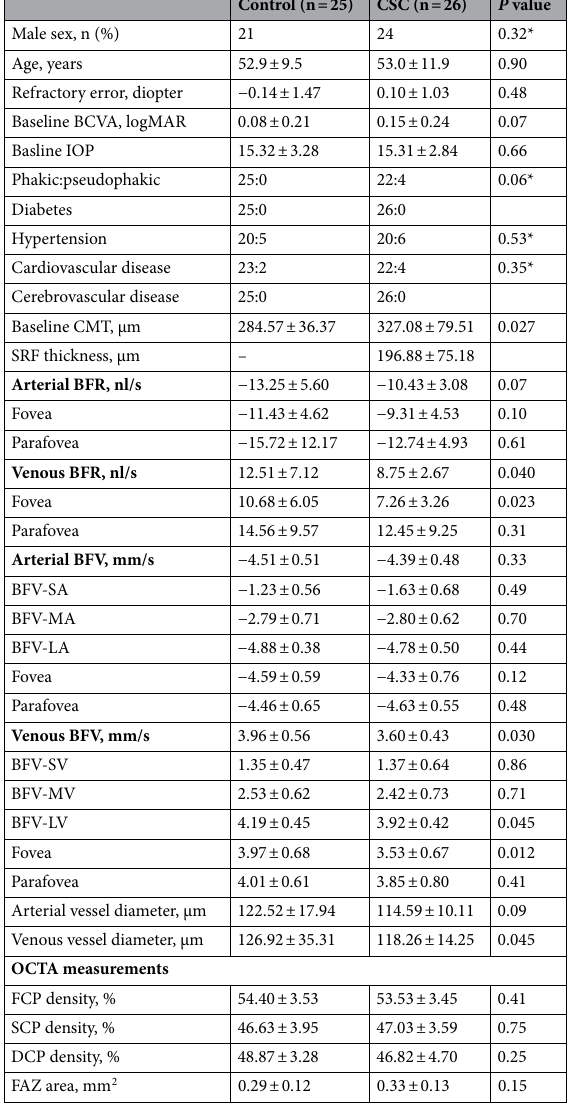
Table 1. Baseline demographics of the CSC patients and control group. *Pearson’s Chi-squared test. All other P values were calculated using Mann–Whitney test. BCVA best-corrected visual acuity, BFR blood flow